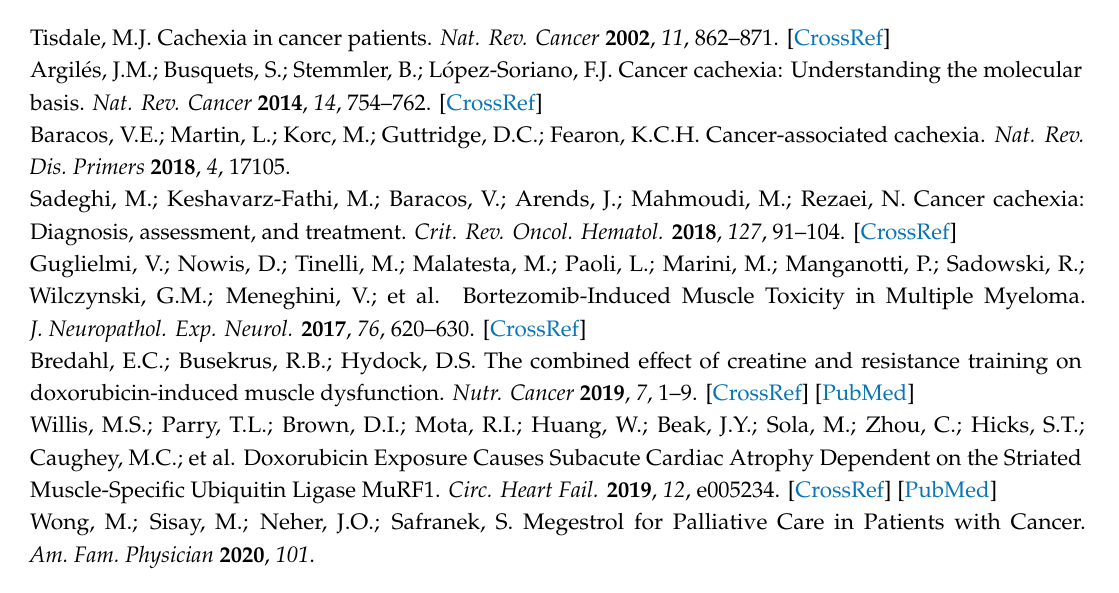
Figure S1: proteomic signature, Figure S2: protein expression of selected proteins, Figure S3: representative complete western